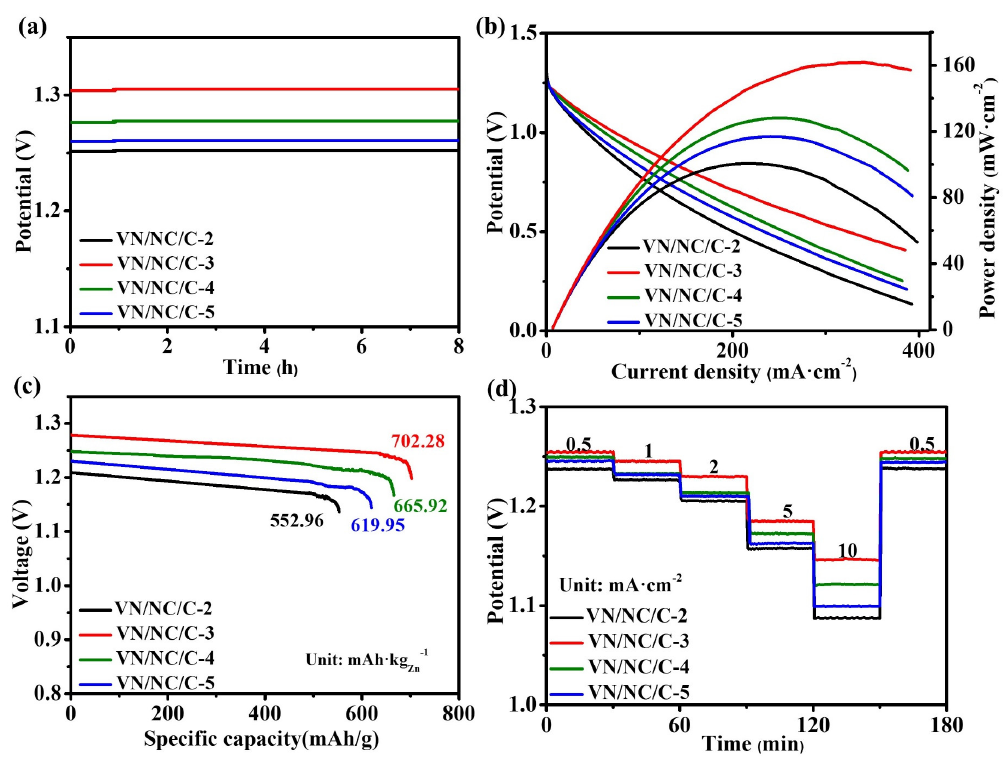
Figure 5. ( a ) Open circuit voltage, ( b )Polarization and corresponding power density curves, ( c ) discharge curves of the VN/NC/C-x based Zn–air batteries. ( d ) Galvanostatic discharge curves of the battery at different current densities.